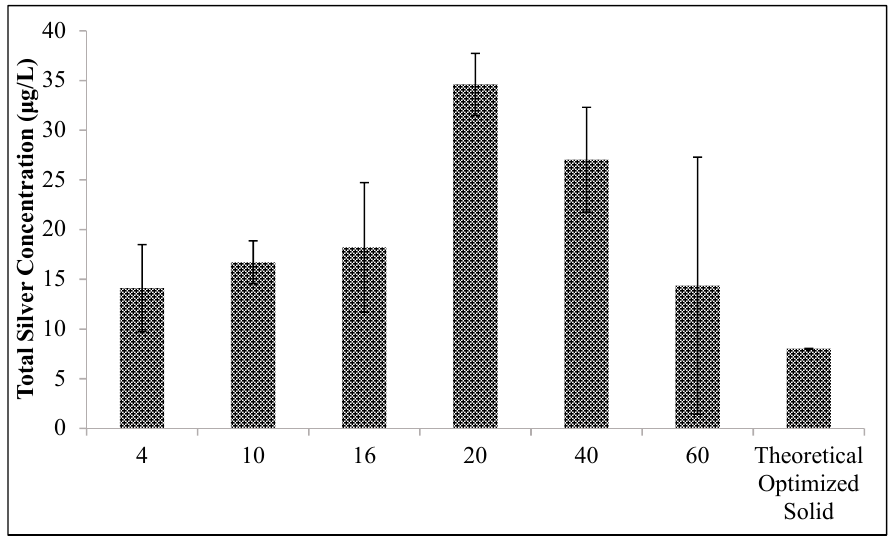
Figure 5. Total silver concentration of 10 grams of crushed clay tablets in 300 mL of tap water (equivalent to approximately two solid tablets containing 1g of silver each in 10 L) after 24 hours as a function of the particle mesh size. Error bars represent standard error. Last bar represents the theoretical silver release after 24 hours of two solid tablets embedded with 1 g of silver each, made using the optimized firing protocol and compression pressure, in 10 L of tap water.